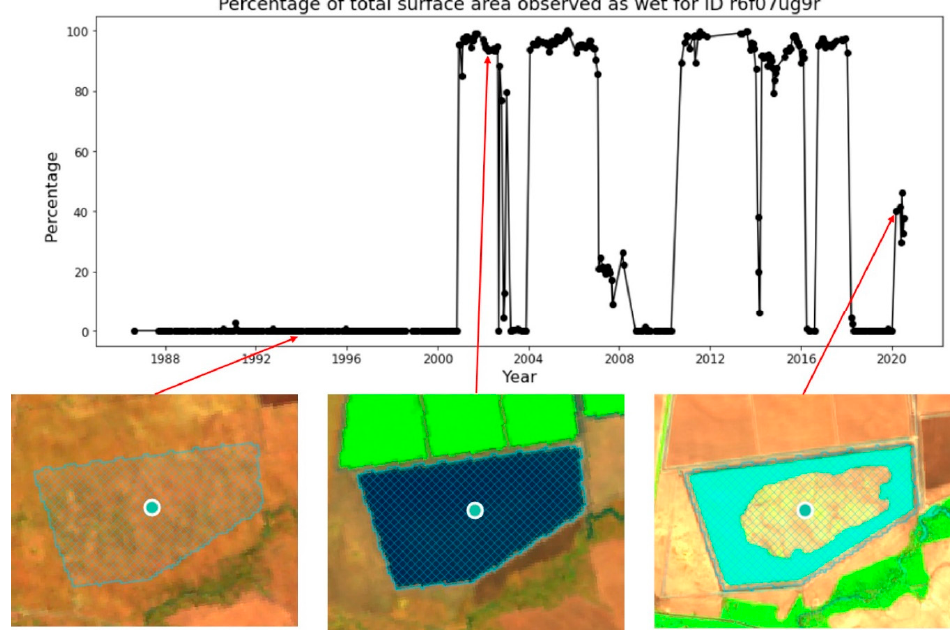
Figure 8. Time series of the change in the percentage of total surface area observed as water for waterbody ID r6f07ug9r. The corresponding false colour imagery is shown for three time steps, showing the relationship between the time series and the raw imagery.